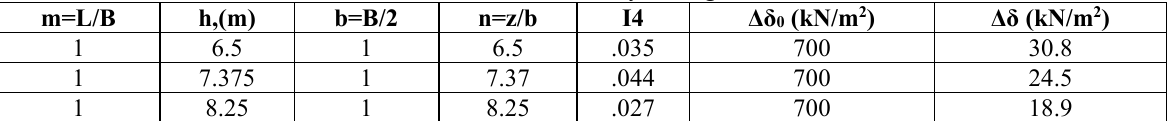
Data for calculation of additional stress due to structure by taking three dimensional effect into account. m=L/B h,(m) b=B/2 n=z/b